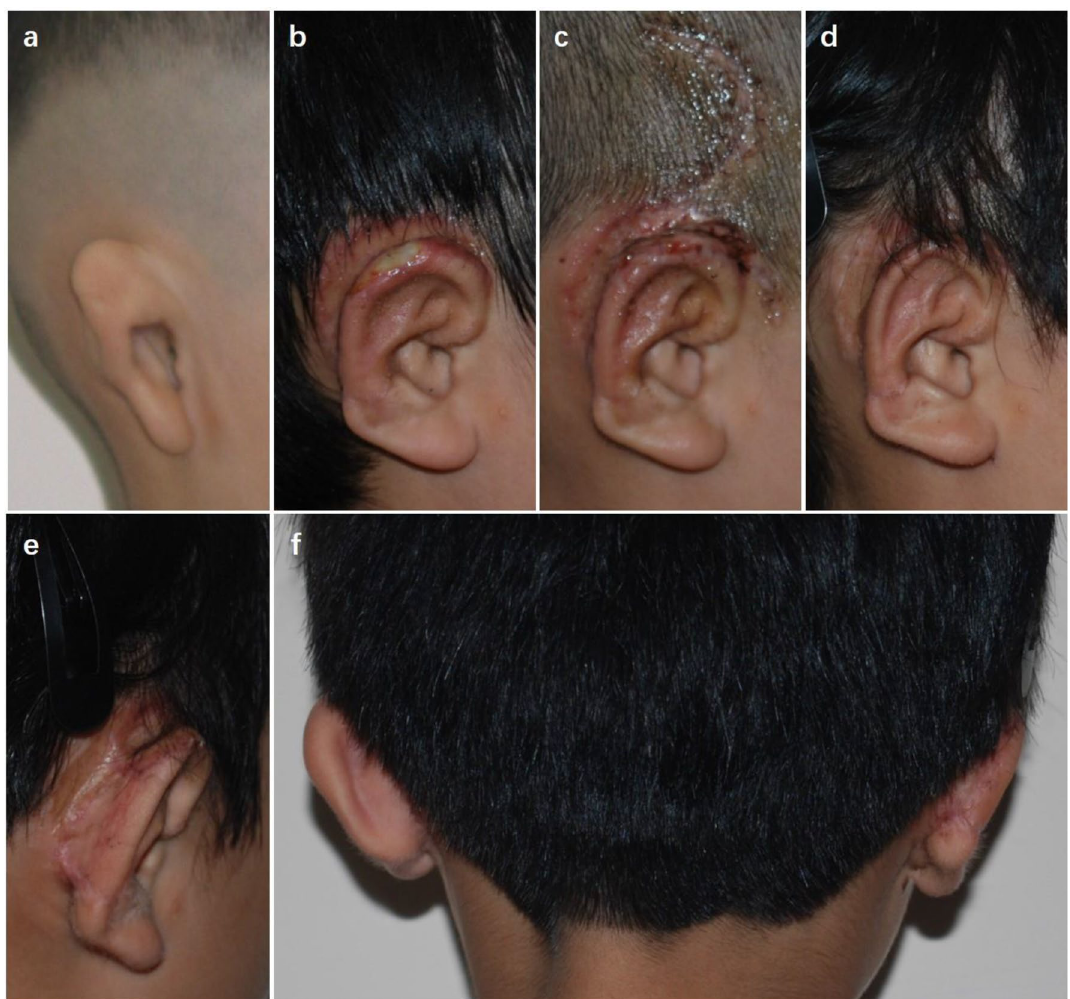
Figure 4. A patient with fascial necrosis and cartilage exposure at the dorsal part of the helix. ( a ) An 8-year-old boy presented with congenital microtia. ( b ) Cartilage exposure of approximately 2 cm 2 at the superior dorsal part of the helix was found 3 weeks after surgery. ( c ) Two weeks after the salvage operation with TPF and skin graft. ( d ) Postoperative oblique view 6 months after the repair operation. ( e ) Postoperative oblique rear view showing that the cephaloauricular sulcus was deep and no obvious hypertrophic scars were observed. ( f ) Dorsal view showing that the cephaloauricular angle was